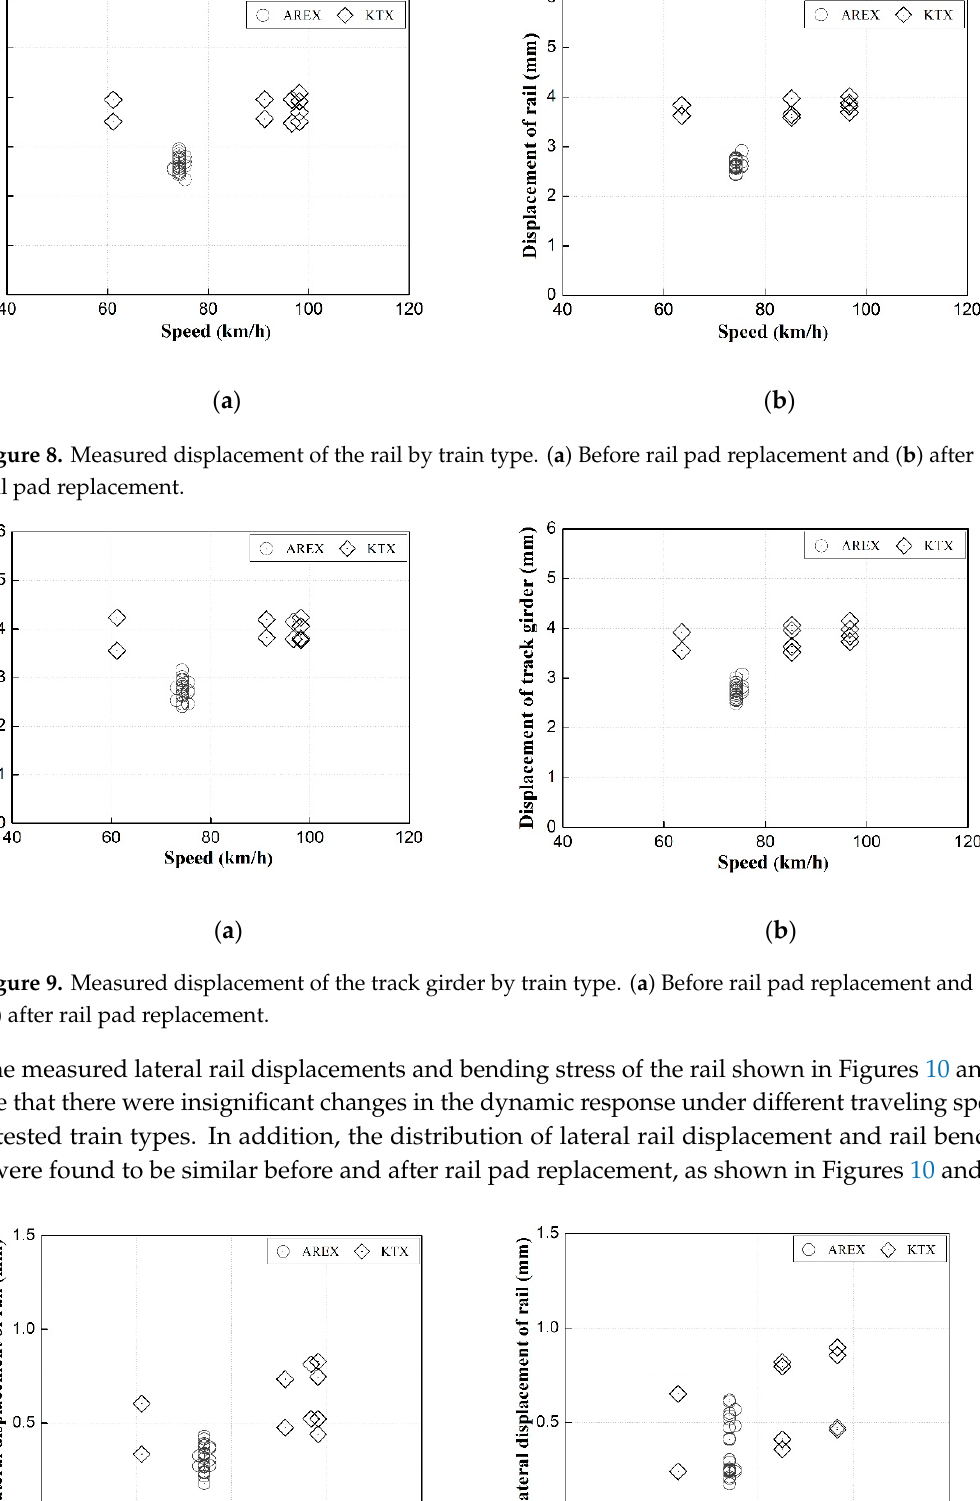
Figure 10. Measured lateral displacement of the rail by train type. ( a ) Before rail pad replacement and ( b ) after rail pad replacement.